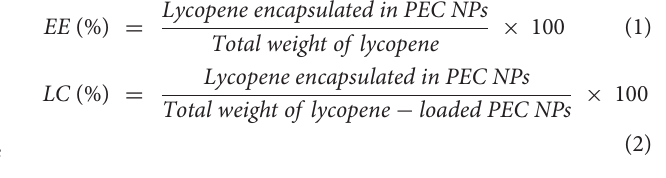
Frontiers in Nutrition |